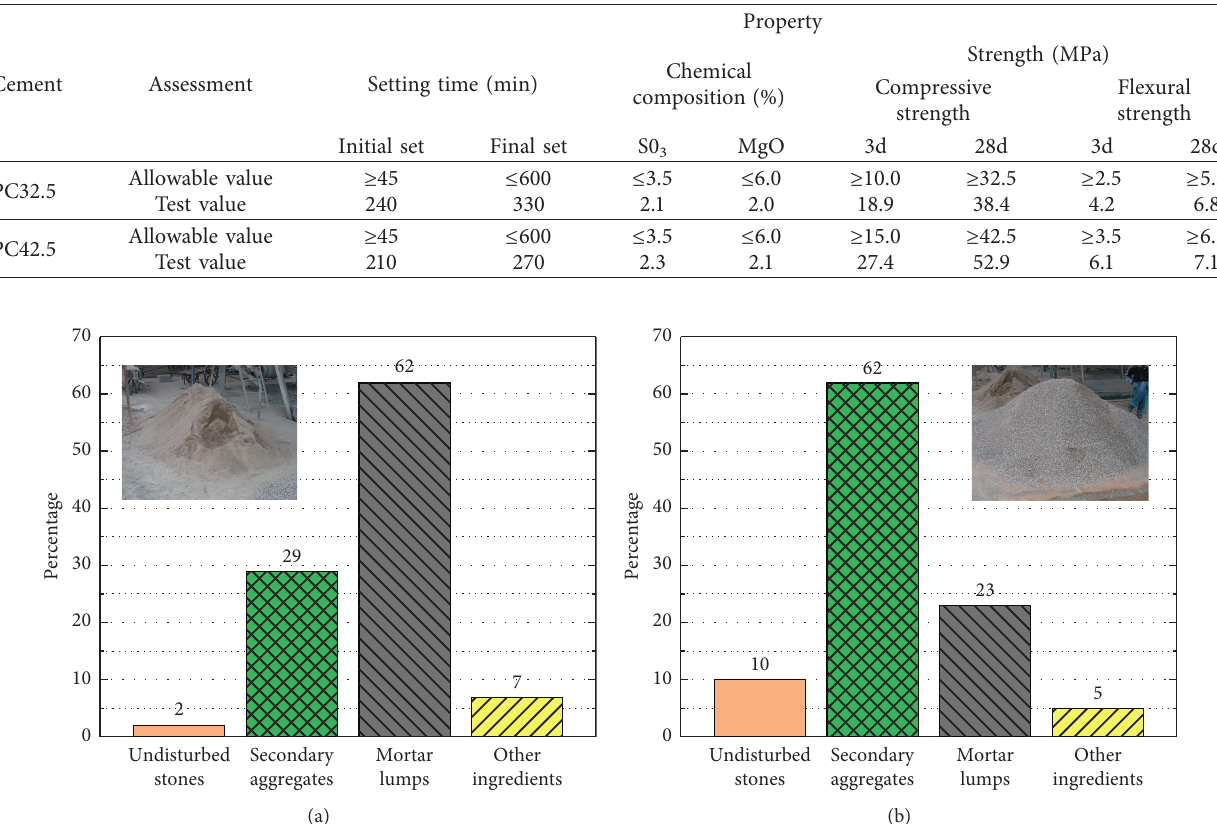
Table 1: Physical and mechanical properties of